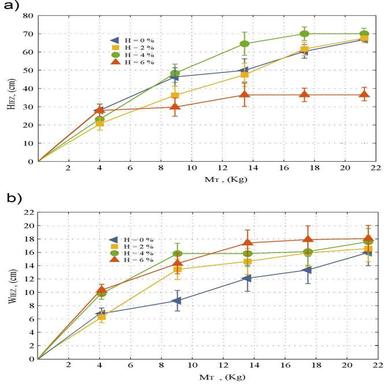
a) IEZ height and b) IEZ width as a function of accumulated masses for different moisture contents.